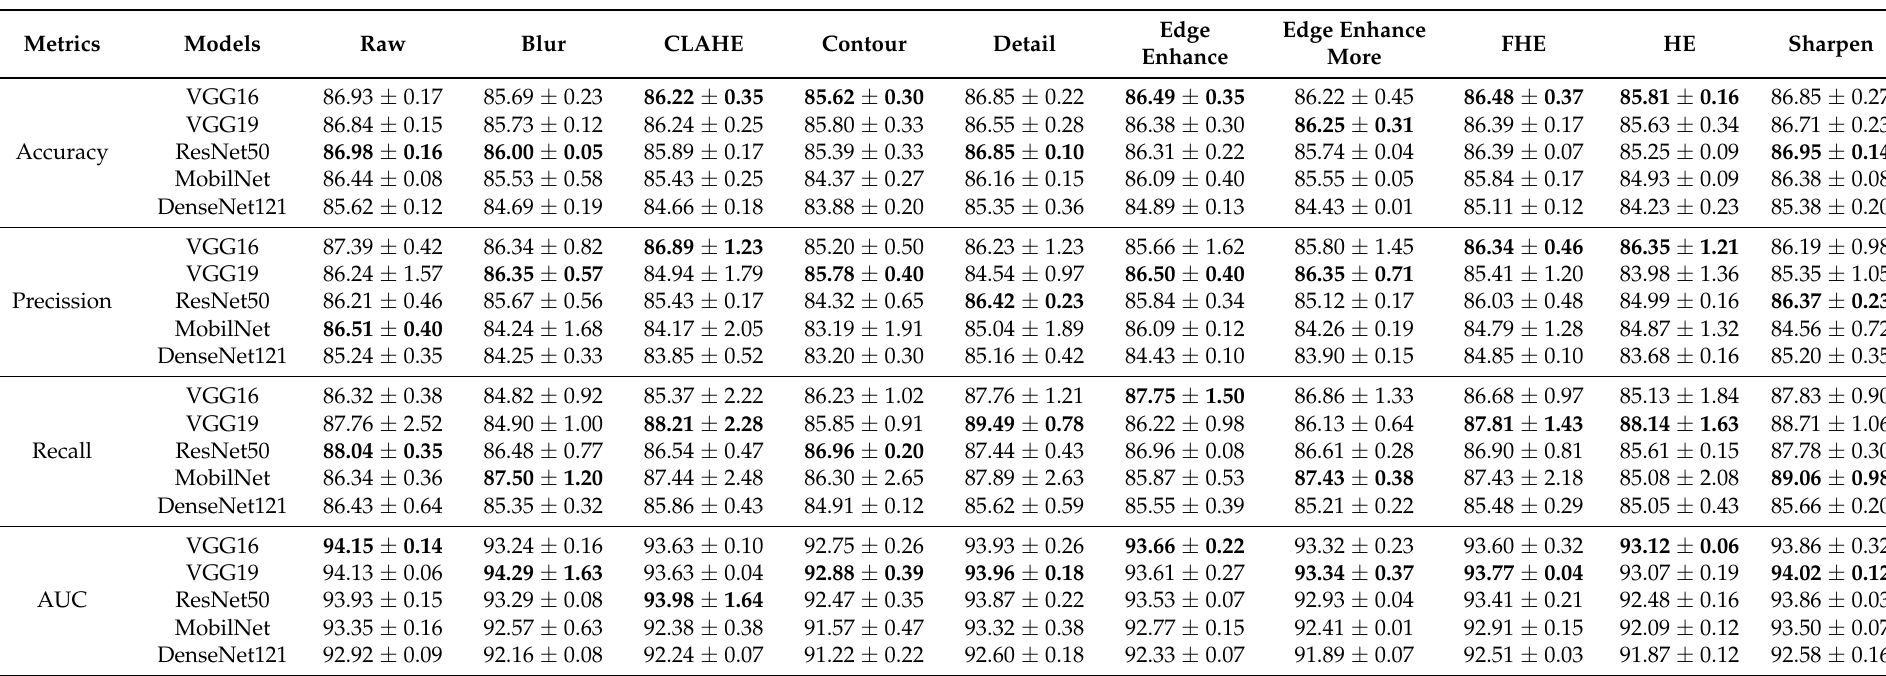
Table 4. Comparative analysis ( µ ± σ ) of the performance of the different models and filters employed. In bold, the best result of all models for a fixed